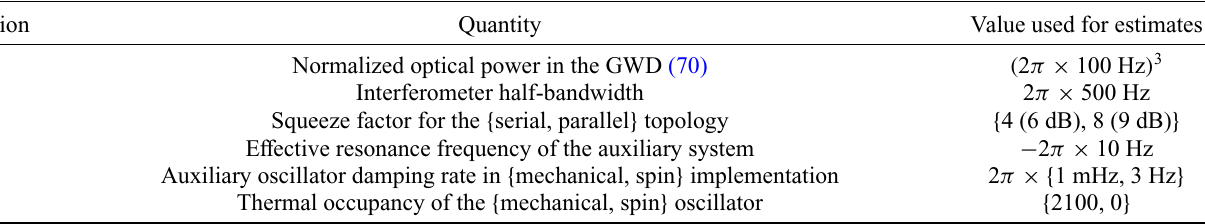
TABLE I. The main parameters and their numerical values used in this paper.